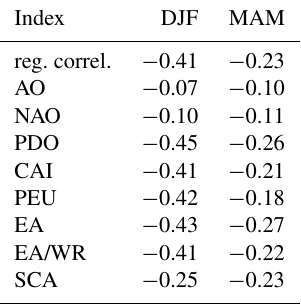
Table 2. Areal average of seasonal (winter and spring) partial cor- relations between 1000hPa temperature at TP and the Greenland